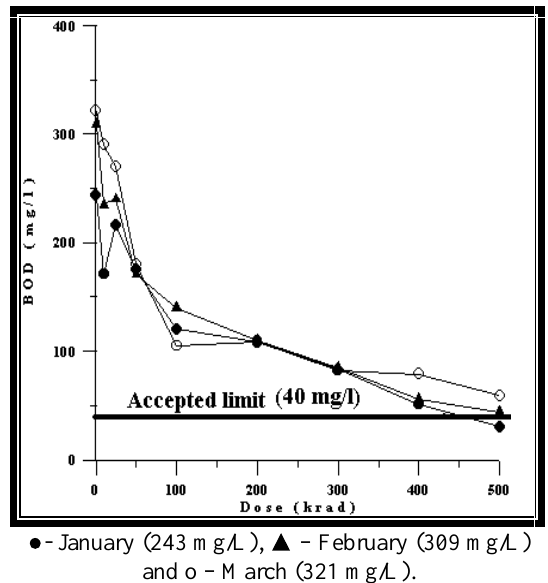
concentration of irradiated sample of 5 5.